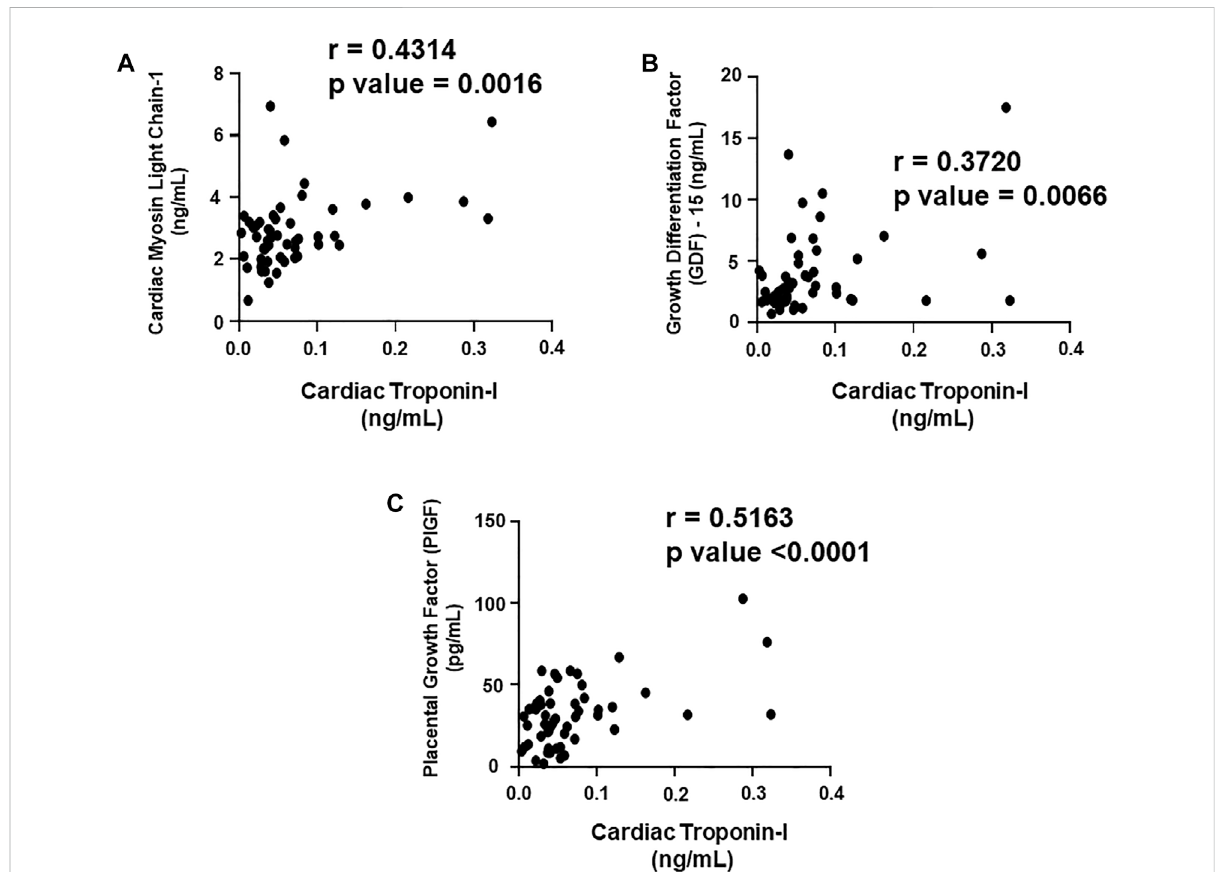
FIGURE 3 Correlation analysis of cardiac troponin I with plasma biomarkers. Correlation analysis was performed using a scatter plot between cardiac troponin I and plasma biomarkers, (A) cardiac myosin light chain 1 (cMLC1), (B) growth differentiation factor 15 (GDF-15) and (C) placental growth factor (PIGF). Pearson ’ s r coef fi cient was used to determine the extent of correlation and statistical signi fi cance was obtained by two-tailed p -value. Each plot independently demonstrates the correlation (Pearson ’ s r coef fi cient) and signi fi cance ( p —